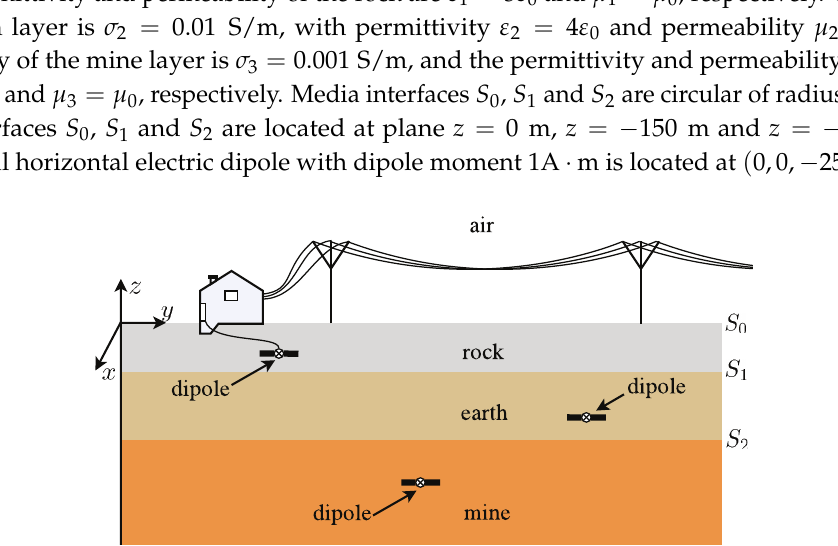
Figure 6. The z -component electric field propagation and the y -component magnetic field